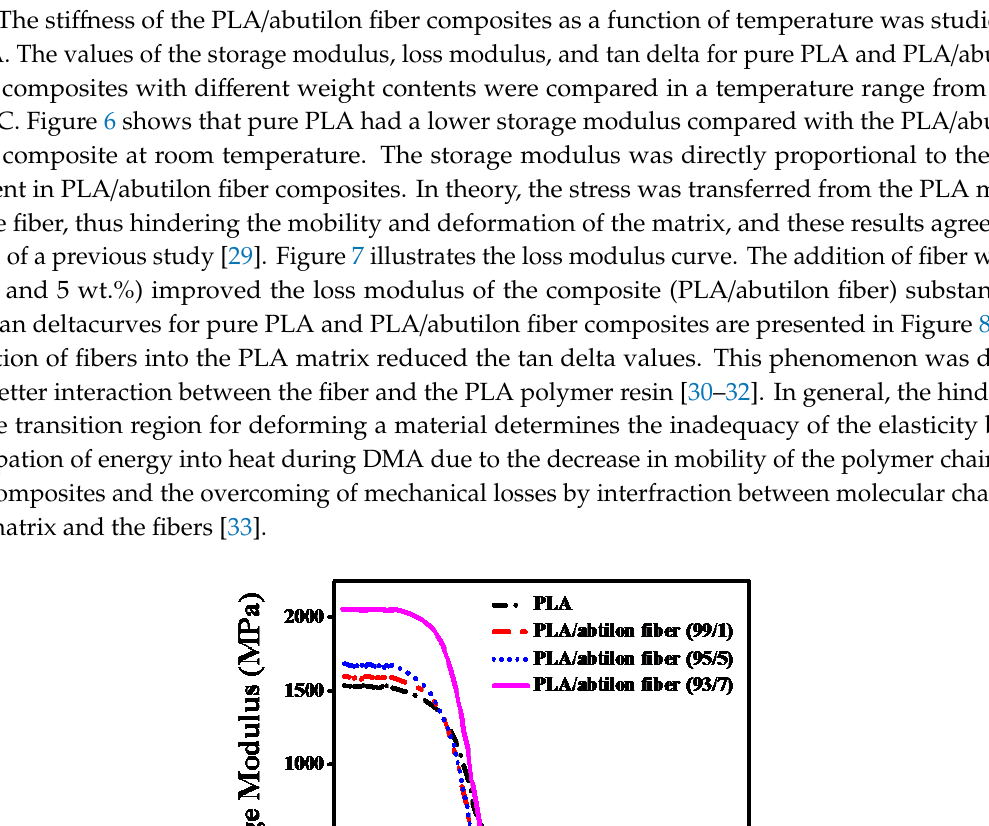
Figure 7. The loss modulus of the composite samples (PLA/abutilon fiber).